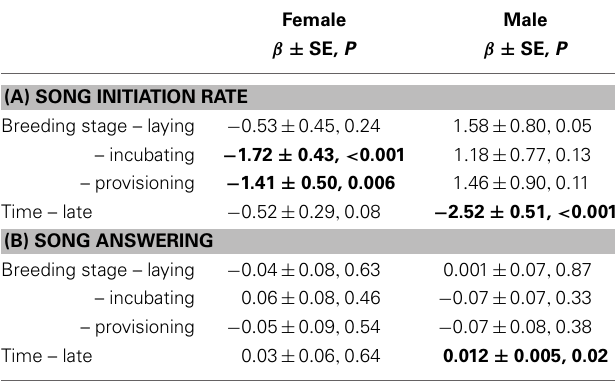
Table 2 | Diurnal and breeding stage variation in